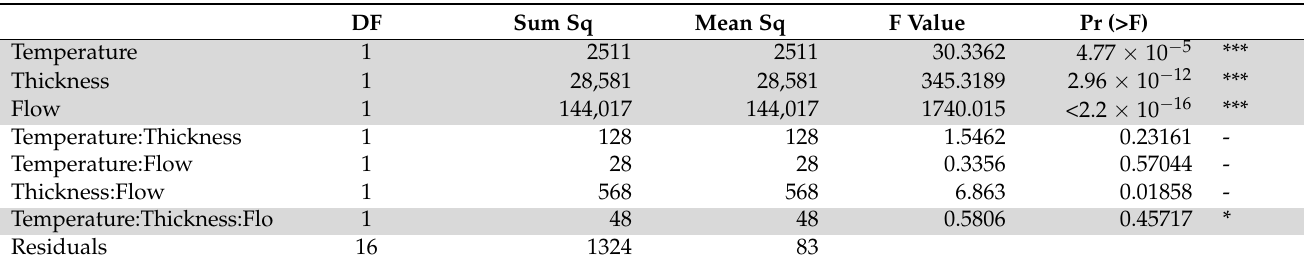
Table 10. Statistical significance of the effects of the printing parameters and their interactions on samples tensile strength.